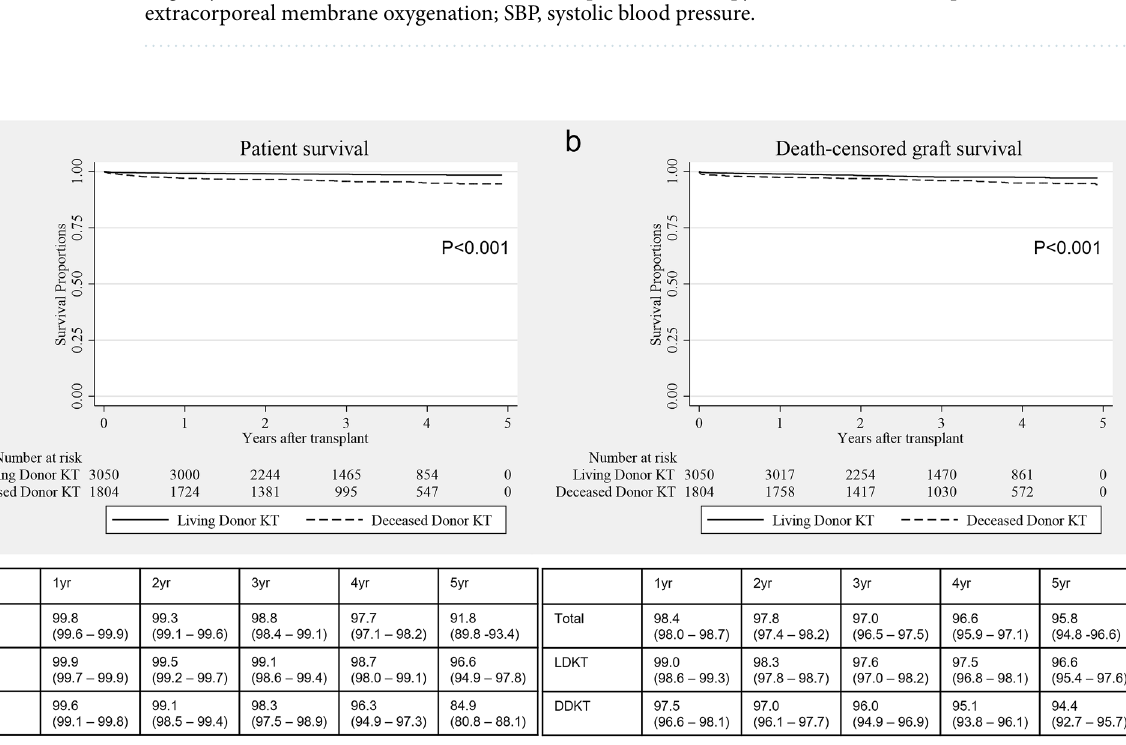
Figure 1. Patient ( a ) and death-censored graft ( b ) survival of Korean Organ Transplantation